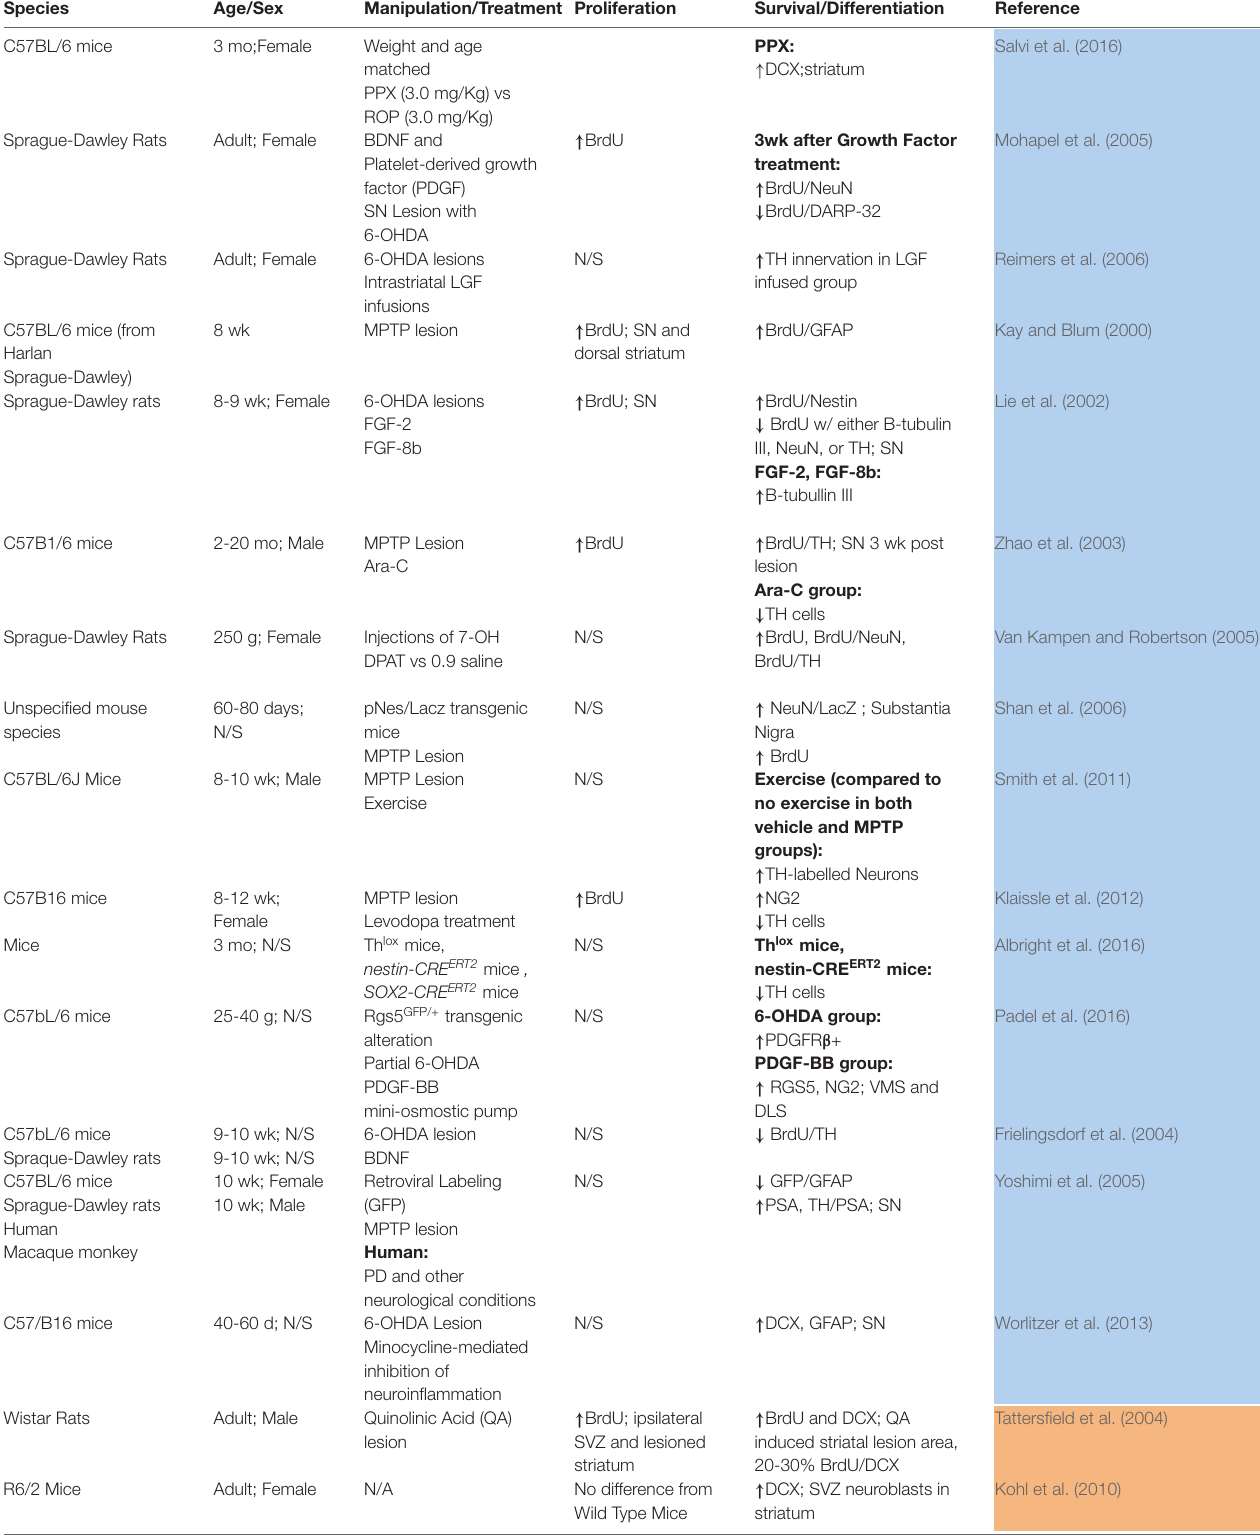
TABLE 2 | Summary of studies that have evaluated adult neurogenesis in the striatum and/or substantia nigra in models of Parkinson’s disease (PD; blue) or Huntington’s disease (HD; orange). Species Manipulation/Treatment Proliferation